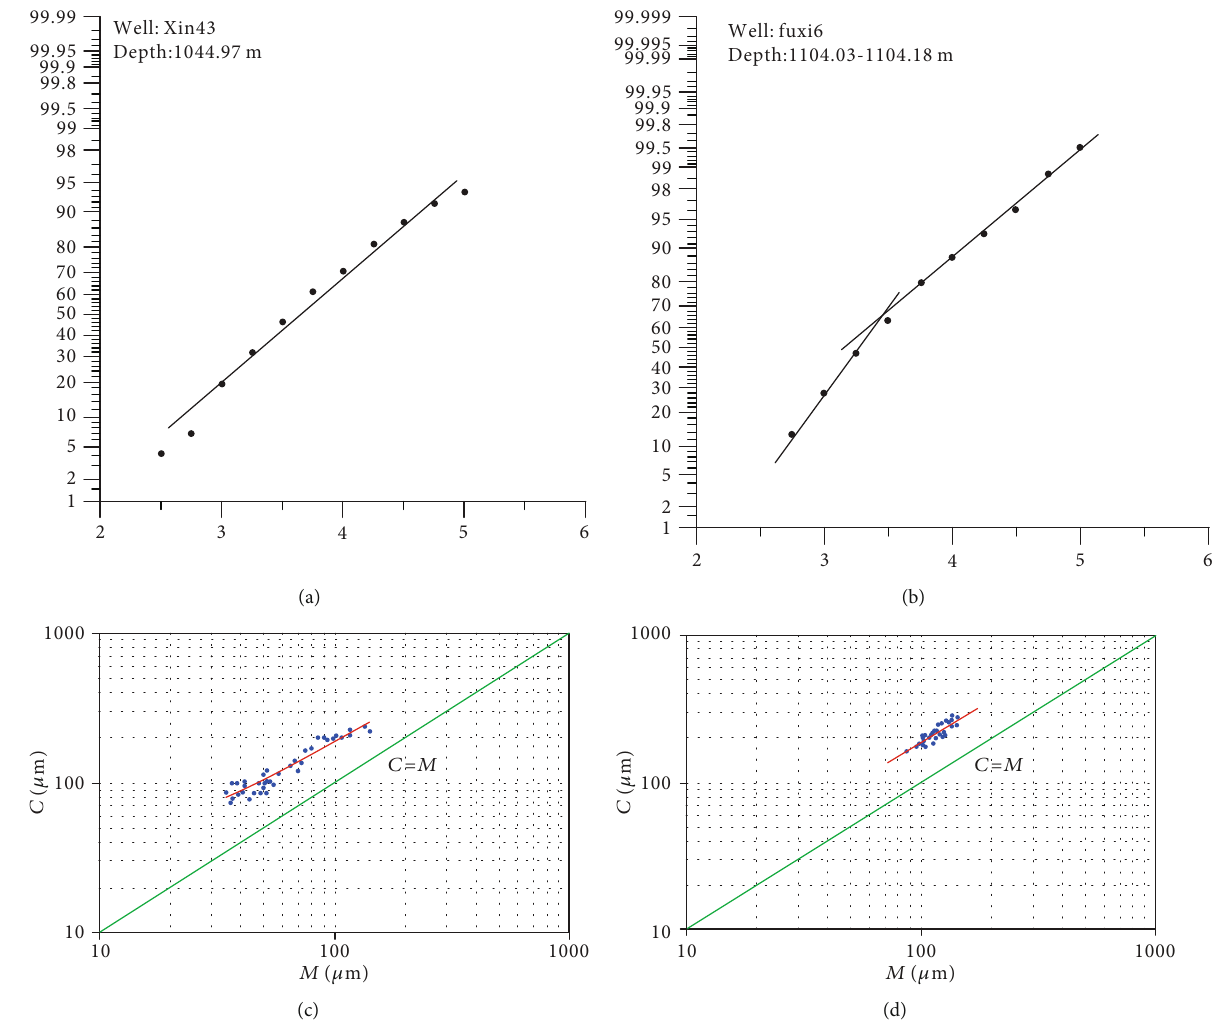
Figure 6: The grain size accumulation curve and C-M diagram in the study area: (a) the grain size accumulation curve, well X43; (b) the grain size accumulation curve, well FX6; (c) the C-M diagram, well X43; (d) the C-M diagram, well